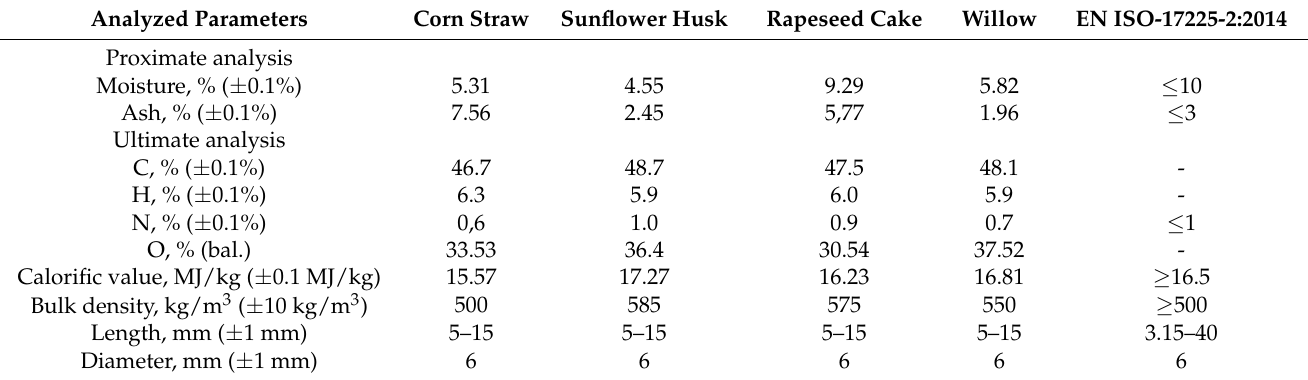
Table 2. A comparison of the selected physicochemical properties and elemental composition for pellets made of straw, sunflower husk, rapeseed cake, and Table 1. Comparison of fuel feed rate and air flow during combustion of straw, sunflower husk, rapeseed cake, and willow pellets.